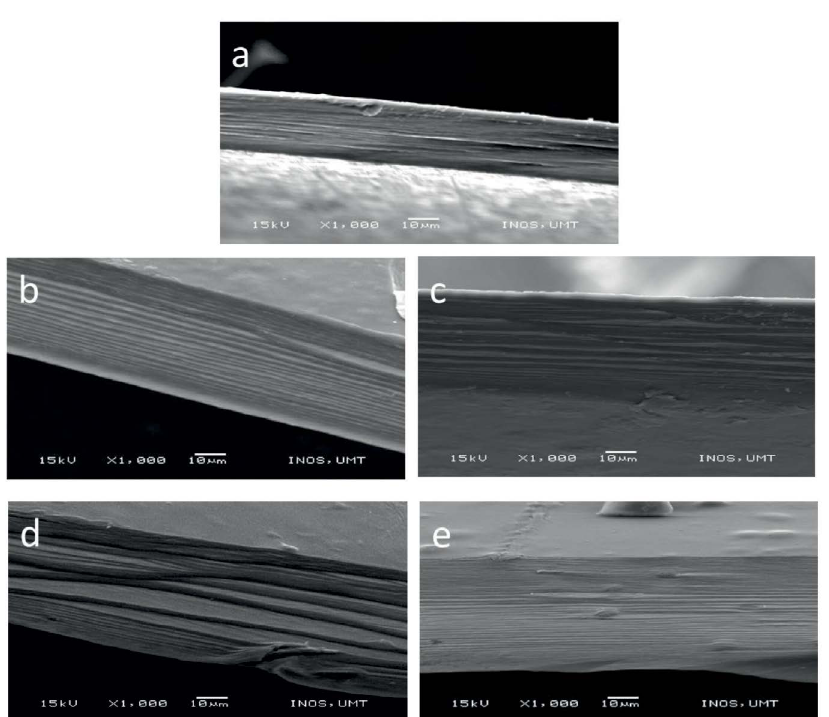
Fig. 2. Scanning electron microscopy images of cross-sectional area of (a) GG, (b) GG-NOR001, (c) GG-NOR01, (d) GG-NOR05, and (e) GG-NOR1